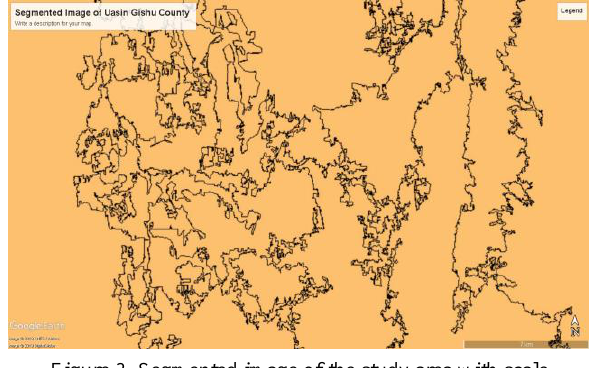
Figure 3. Segmented image of the study area with scale parameter 1600, shape 0.1 and compactness 0.5